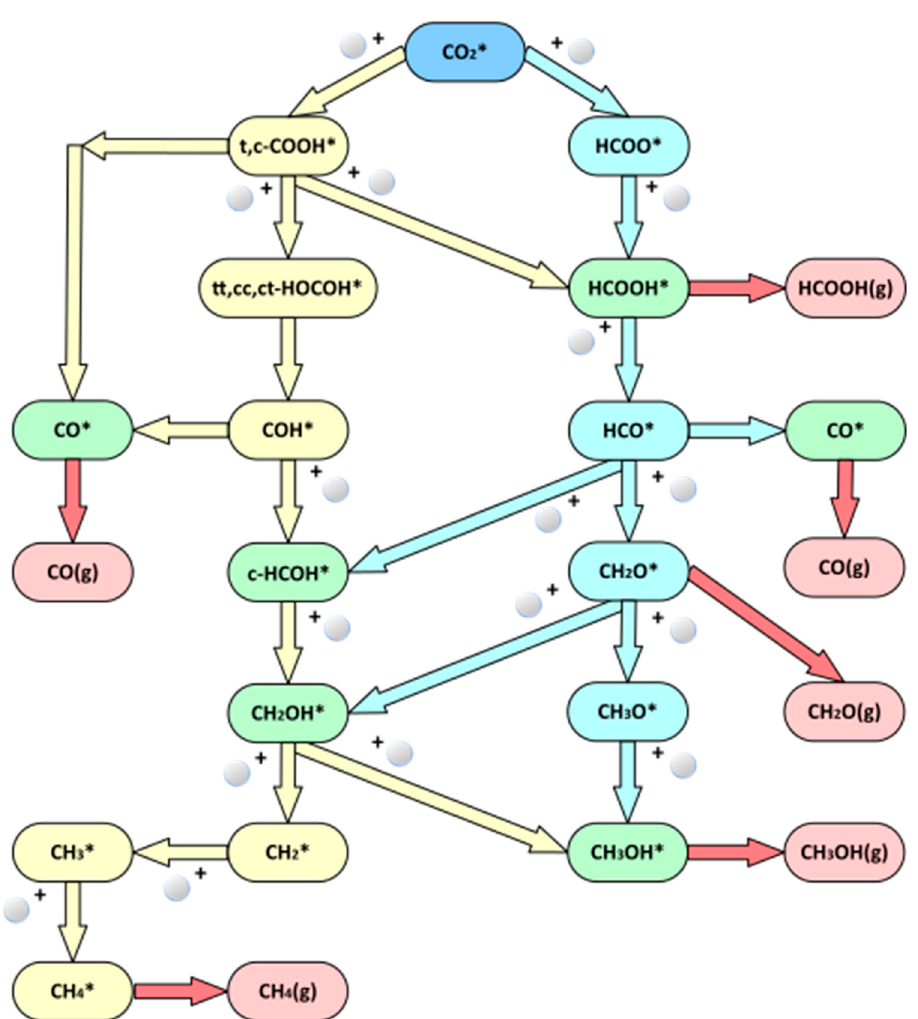
Figure 2. The possible reaction networks of CO 2 hydrogenation to CO, HCOOH, CH 2 O, CH 3 OH, and CH 4 at the TaC (111) surface. It should be noted that the adsorbed intermediates on the surface are indicated by the symbol *.